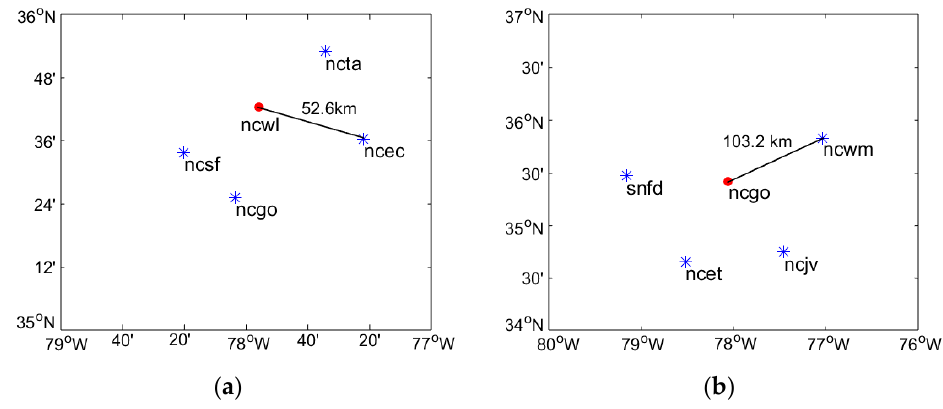
Figure 1. Distribution of stations. ( a ) The distribution of medium-scale reference networks; ( b ) the distribution of large-scale reference networks. The blue asterisks represent reference stations and red dots represent user stations.